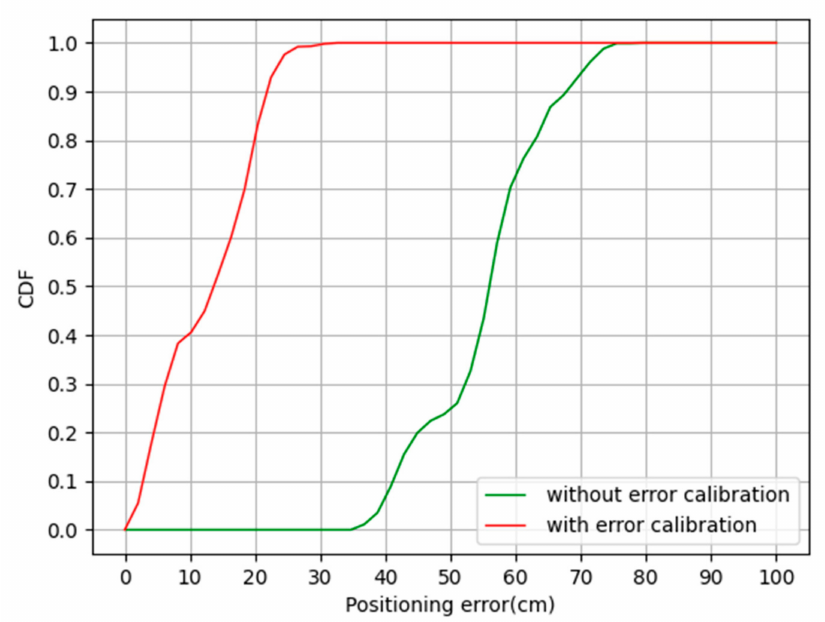
Figure 8. Positioning error improvement by the error calibration.